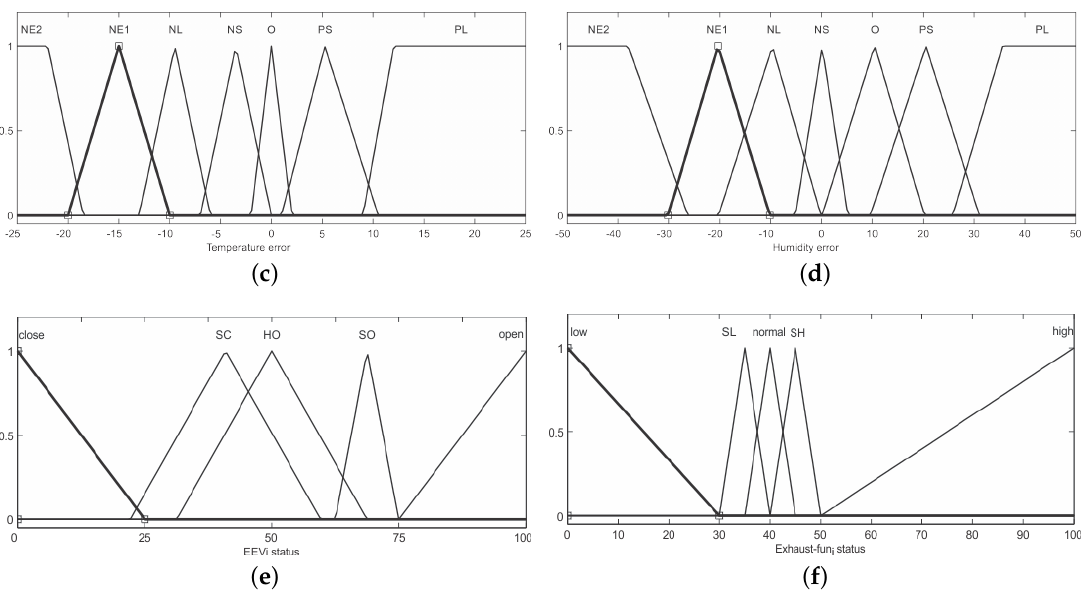
Figure 3. Membership function temperature, humidity, error temperature and error in humidity. ( a ) Input current temperature; ( b ) input current humidity; ( c ) input error temperature; ( d ) input error humidity; ( e ) output control temperature; ( f ) output control